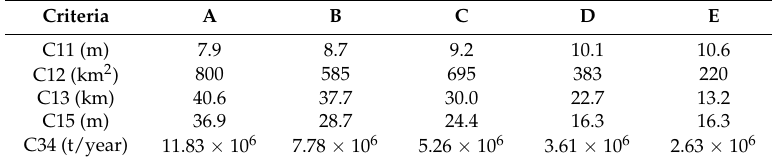
Table 9. The data of the quantitative criteria with respect to the barrages A-E in the Severn Estuary.